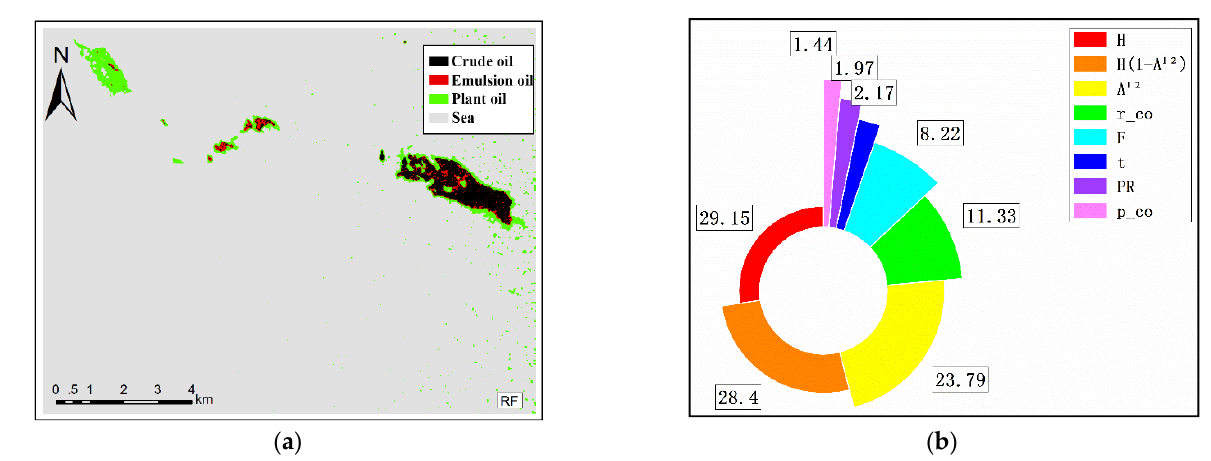
Figure 13. Results of the Random Forest classifier and importance ordering of polarimetric features in study area 3 : ( a ) oil spill detection results; ( b ) variable importance ordering. Table 6. Classification accuracies of the Random Forest classifier in study area 3.